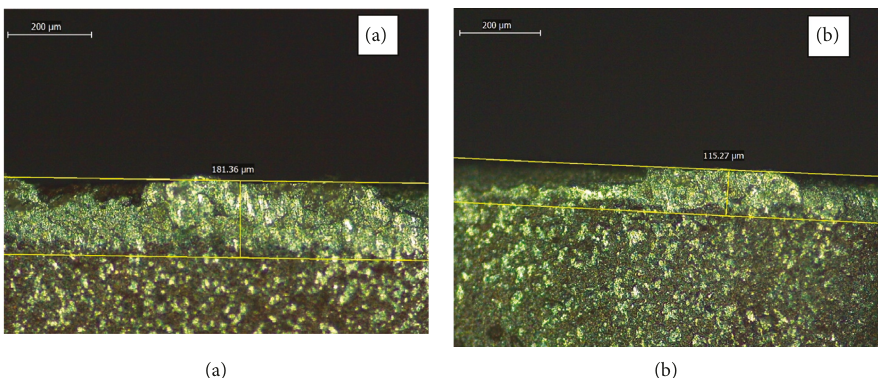
Figure 6: Leica DM570 M microscope showing two-insert flank wear (Vbmax) for experiment number 17: (a) the first insert; (b) the second